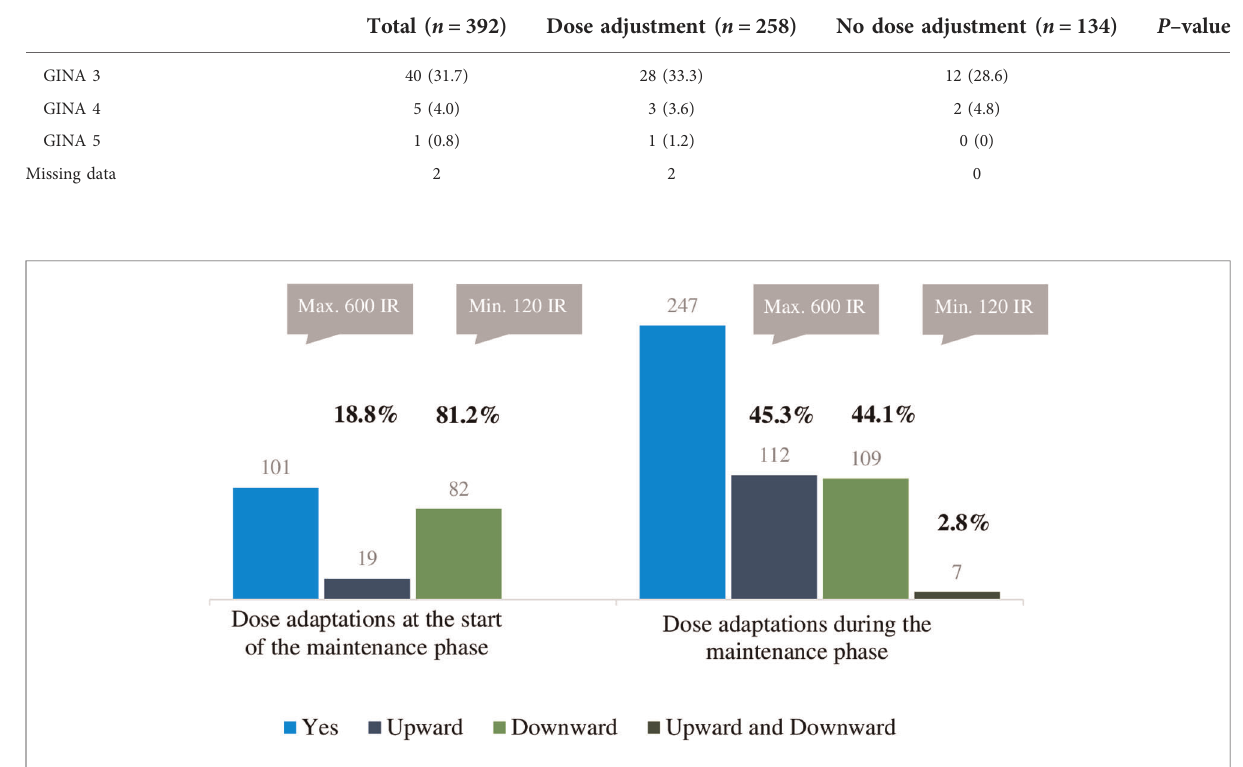
FIGURE 4 Number of patients with dose adaptation (total n =258) and types of dose adjustment during SLIT, as recorded in the